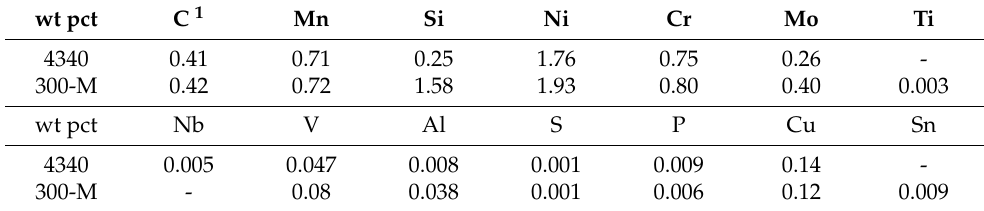
Table 1. Chemical composition of research materials (wt pct).